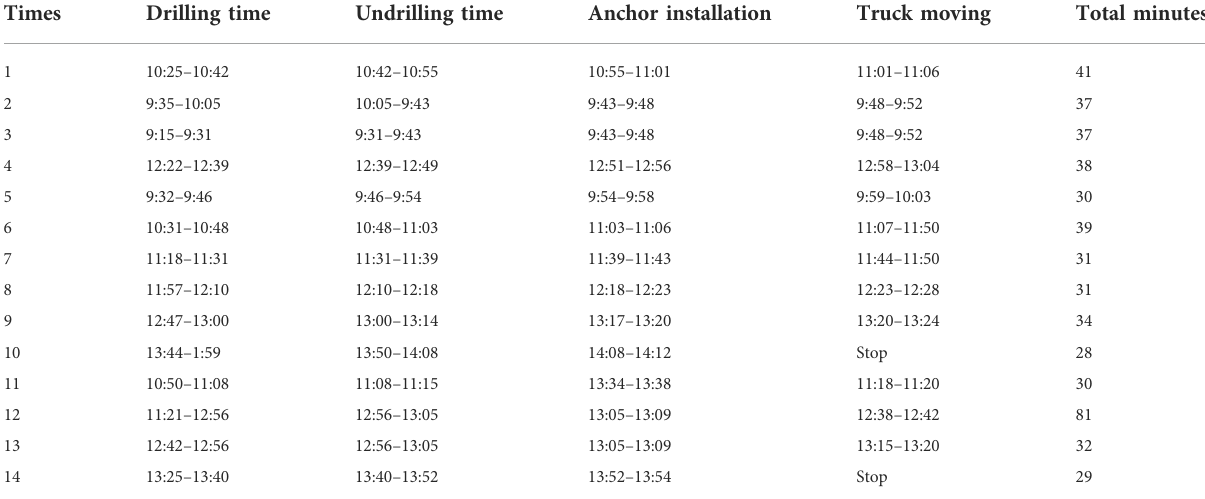
TABLE 8 Test record of the anchor rod drill